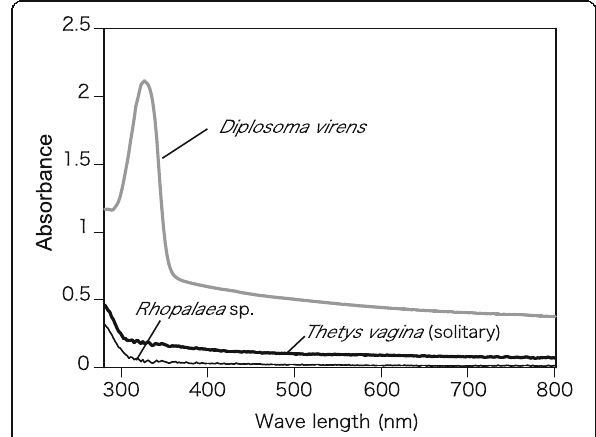
Fig. 2 Absorption spectra of the tunic of Thetys vagina ( black thick line ), Rhopalaea sp. ( black thin line ), and Diplosoma virens ( grey line ). The spectra of T. vagina and Rhopalaea sp. have no prominent peaks, whereas the spectrum of D. virens has an absorption peak due to UV-absorbing substances